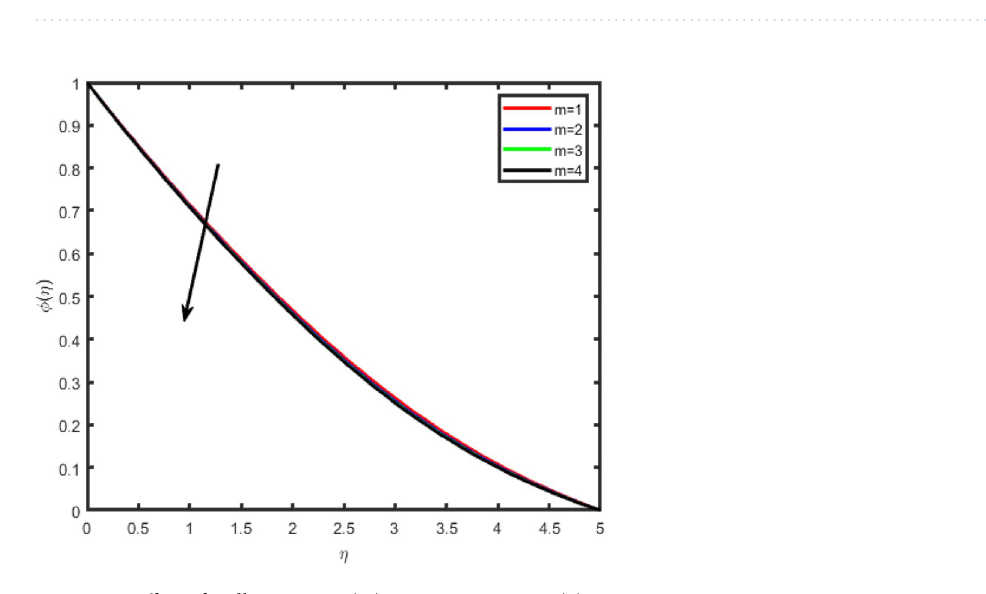
Figure 9. Effect of Hall parameter (m) on concentration